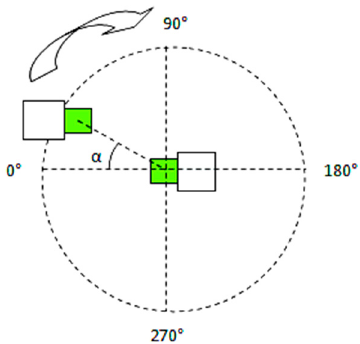
Figure 17. A 360 ◦ face-to-face measurement setup. Figure 17. A 360° face-to-face measurement setup. Figure 17. A 360° face-to-face measurement setup.